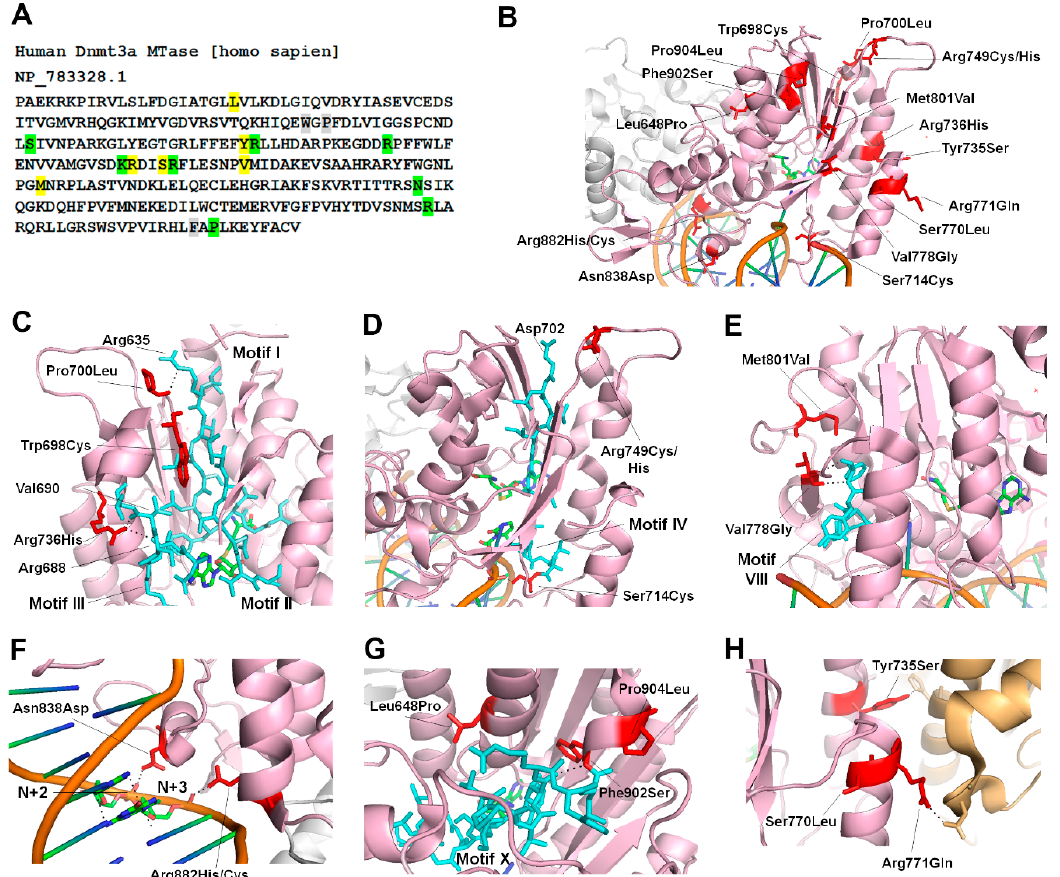
Figure 3. TBRS mutations in the catalytic domain of DNMT3A ( A ) Nucleotide sequence of the hDNMT3A MTase domain. As seen in Figure 2A, variants unique to TBRS are highlighted in yellow, TBRS variants overlapping with hematologic malignancies are highlighted in green, and TBRS variants at the codon that are altered to different amino acids in hematologic malignancies are highlighted in grey. ( B ) Crystal structure of DNMT3A bound to DNA, zoomed in to show only one of the two monomers in the tetrameric structure (PDB: 5YX2). The MTase domain is shown in a pink cartoon structure and the positions of TBRS mutations are shown as stick structures in red. The second monomer of the MTase is shown in grey. ( C – G ) Magnified view of the motifs I-III ( C ), motif IV ( D – E ), motif VIII ( F ), the TRD ( G ), and motif X ( H ) shown as stick structures in blue and the positions of TBRS mutations shown as stick structures in red. The black dotted lines represent interactions with nearby residues or with the DNA. ( H ) The interface between DNMT3A, pink cartoon, and DNMT3L, orange cartoon. The positions of TBRS mutations shown as stick structures in red. The black dotted lines represent interactions with nearby residues of DNMT3L shown as stick structures in orange.